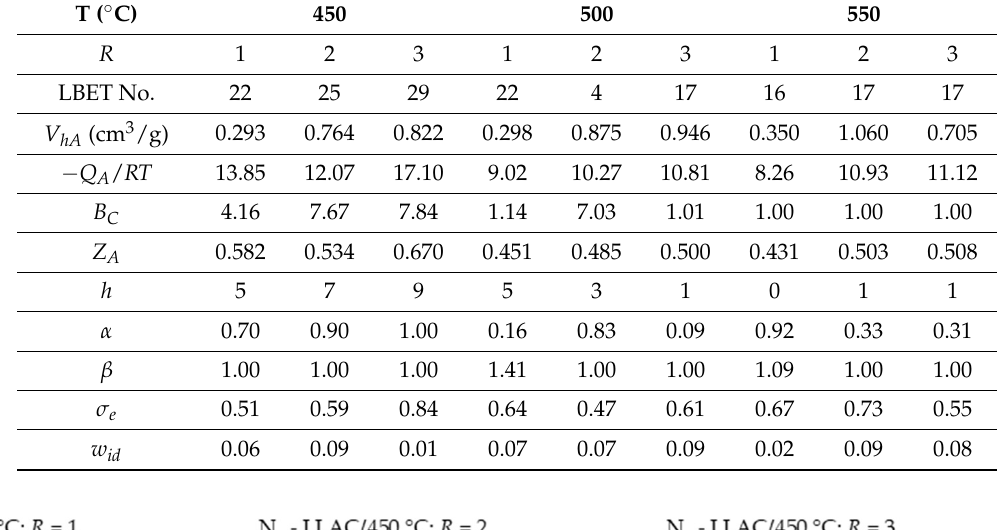
Table 2. The results of the analysis of a microporous structure of nitrogen-doped activated carbons, based on nitrogen adsorption isotherms, determined using the LBET method.